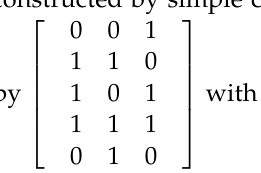
5 × 3, the size that is determined by n × m under thresholds ( k , n , m ). From definition of the